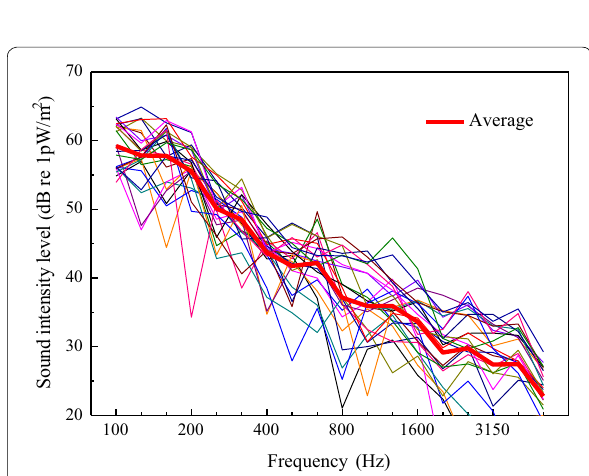
Figure 19 Sound intensity spectrum of the exterior